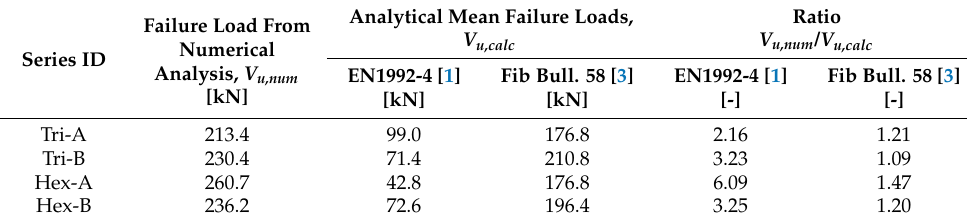
Table 3. Comparison of numerical results with analytically obtained failure loads for the investigated anchor groups loaded parallel to the